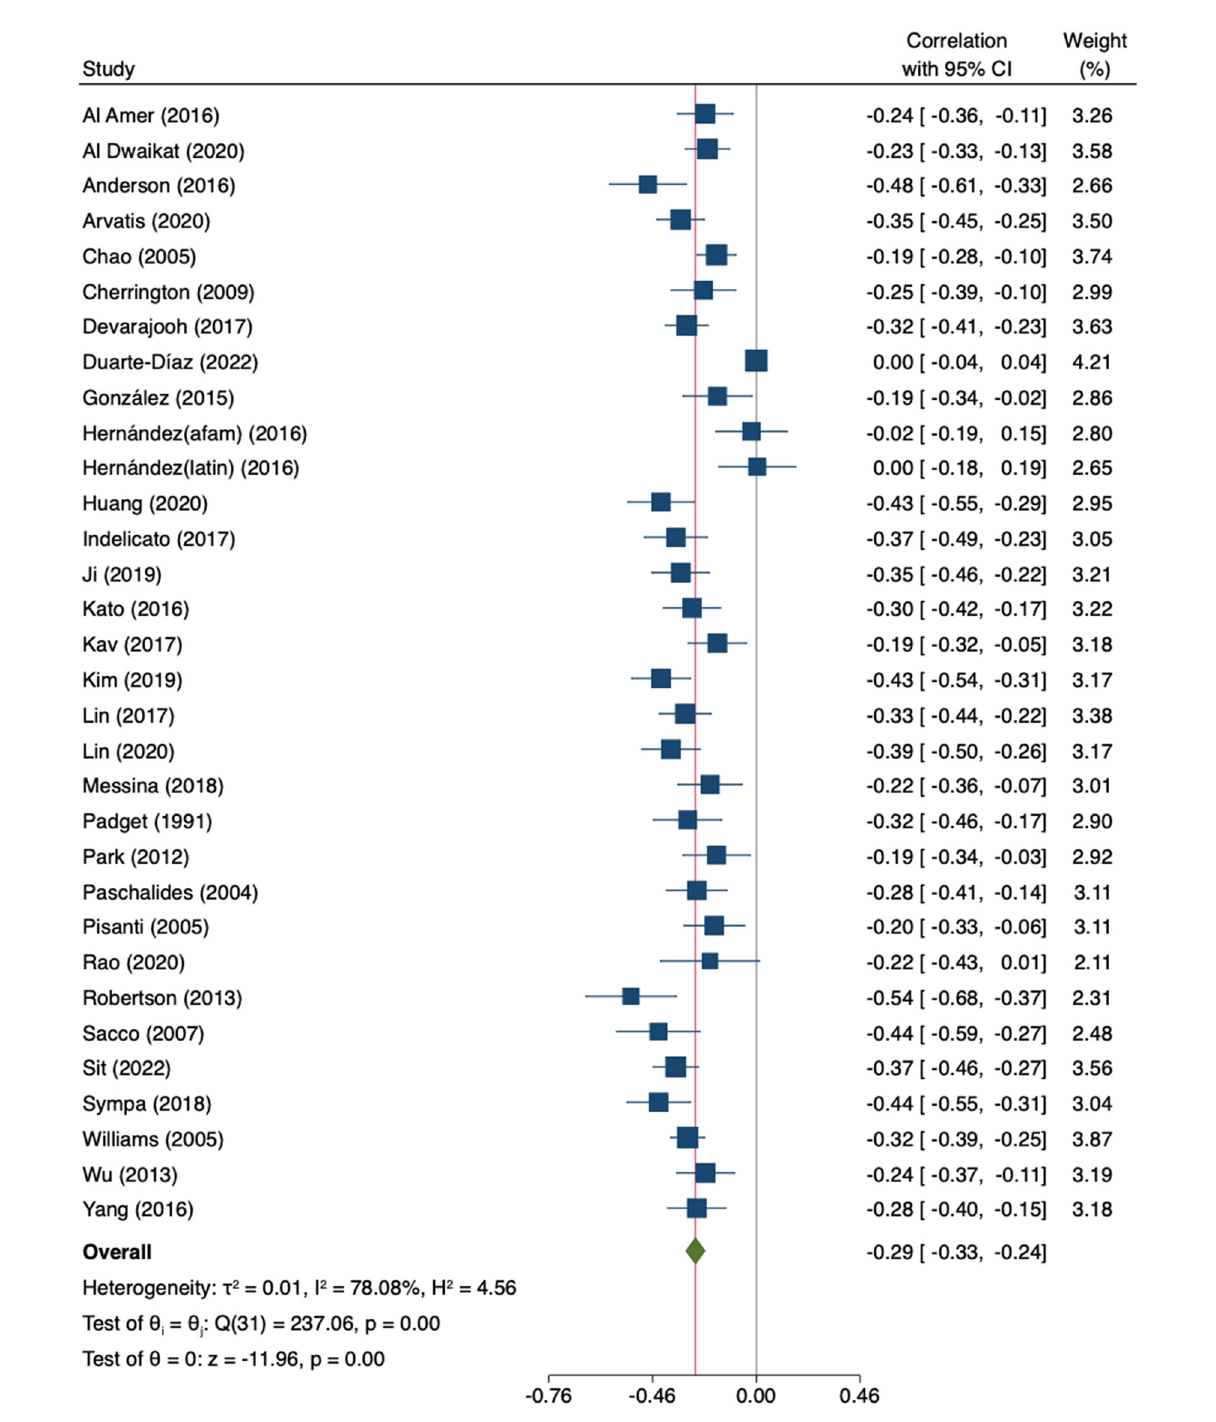
FIGURE5 Random-effects meta-analysis on the association between empowerment and